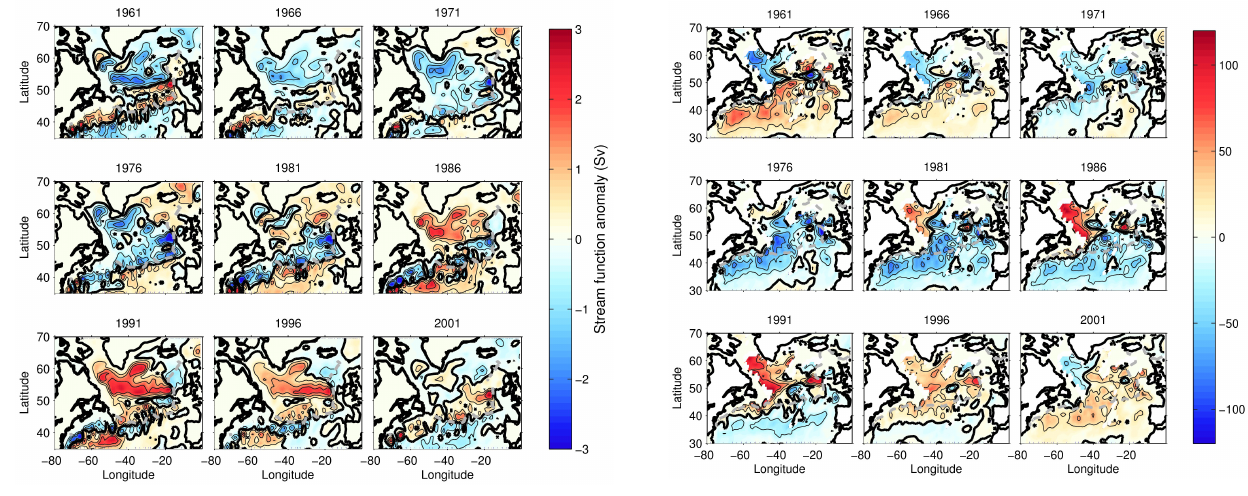
Figure 9. As Fig. 6 but for anomalies of the residual barotropic stream function (“heat flux” Fig. 9. As Fig. 6 but for anomalies of the residual barotropic stream circulation component), which is the difference between the WSC contribution and the full function (“heat flux” circulation component), which is the differ- forcing experiment (Sv). ence between the WSC contribution and the full forcing experiment (Sv).